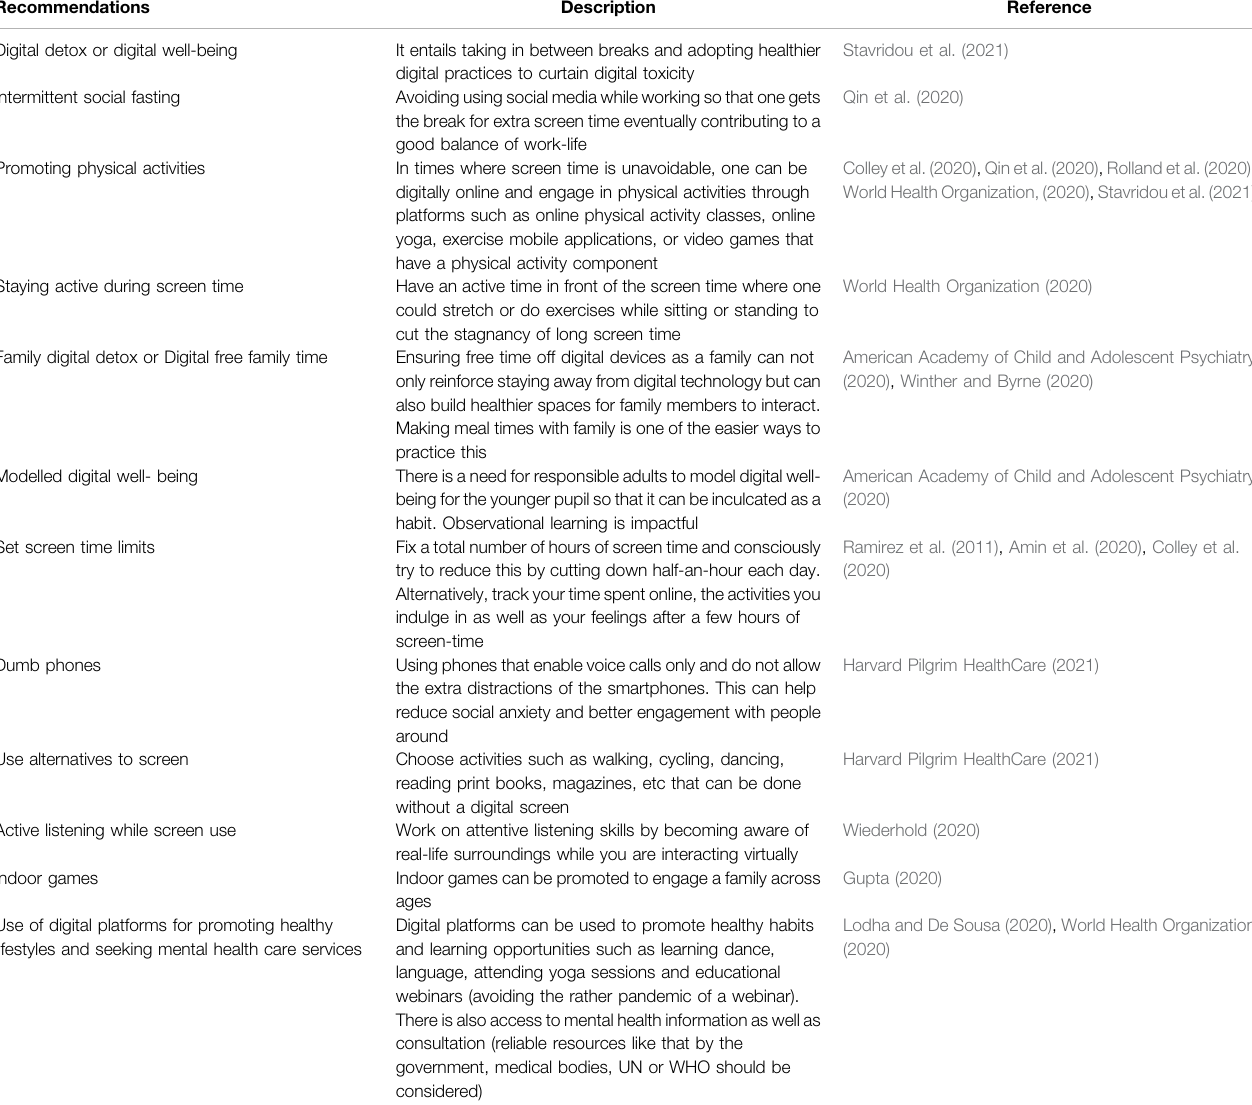
TABLE 2 | Recommendations for reducing screen-time reported in